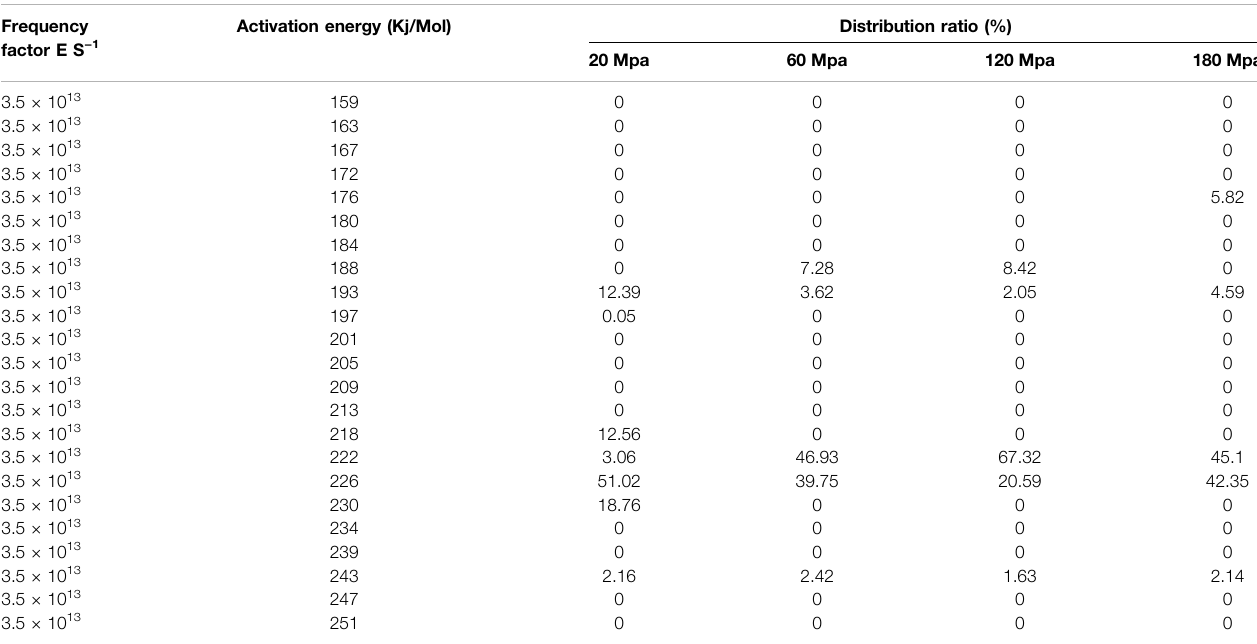
TABLE 2 | Comparison of hydrocarbon generation kinetics under different